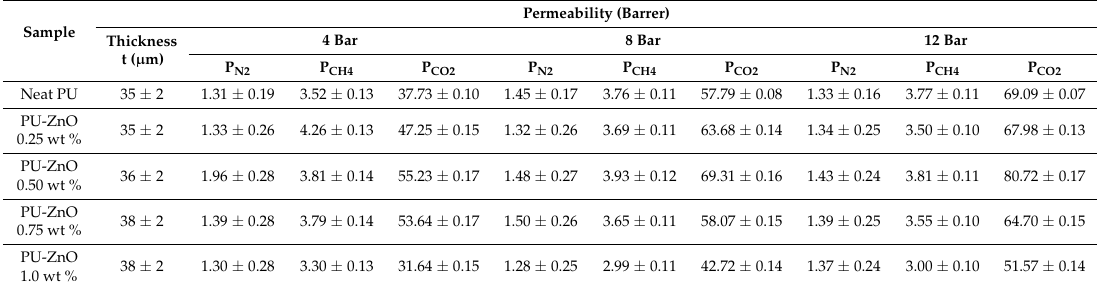
Table 5. Kinetic diameter and condensability of gases.